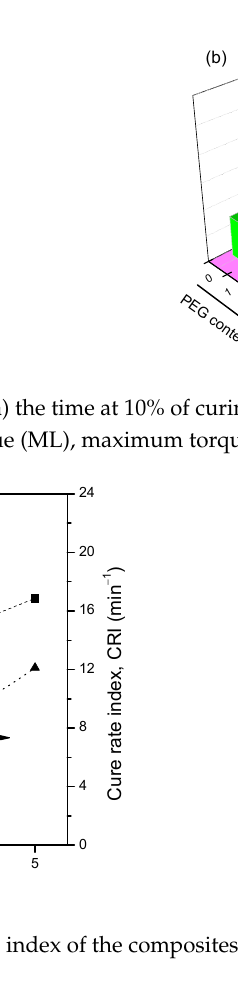
Figure 4. Mooney viscosity and cure rate index of the composites with different polyethylene gly- col (PEG) contents.